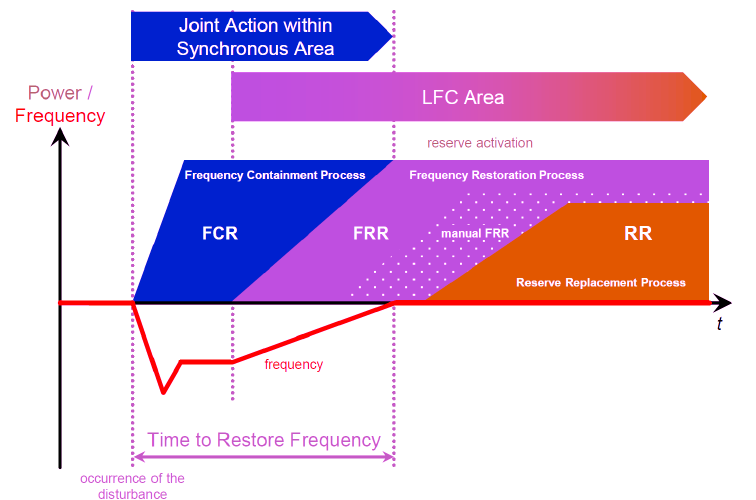
Figure 1. Load-Frequency Control processes over time